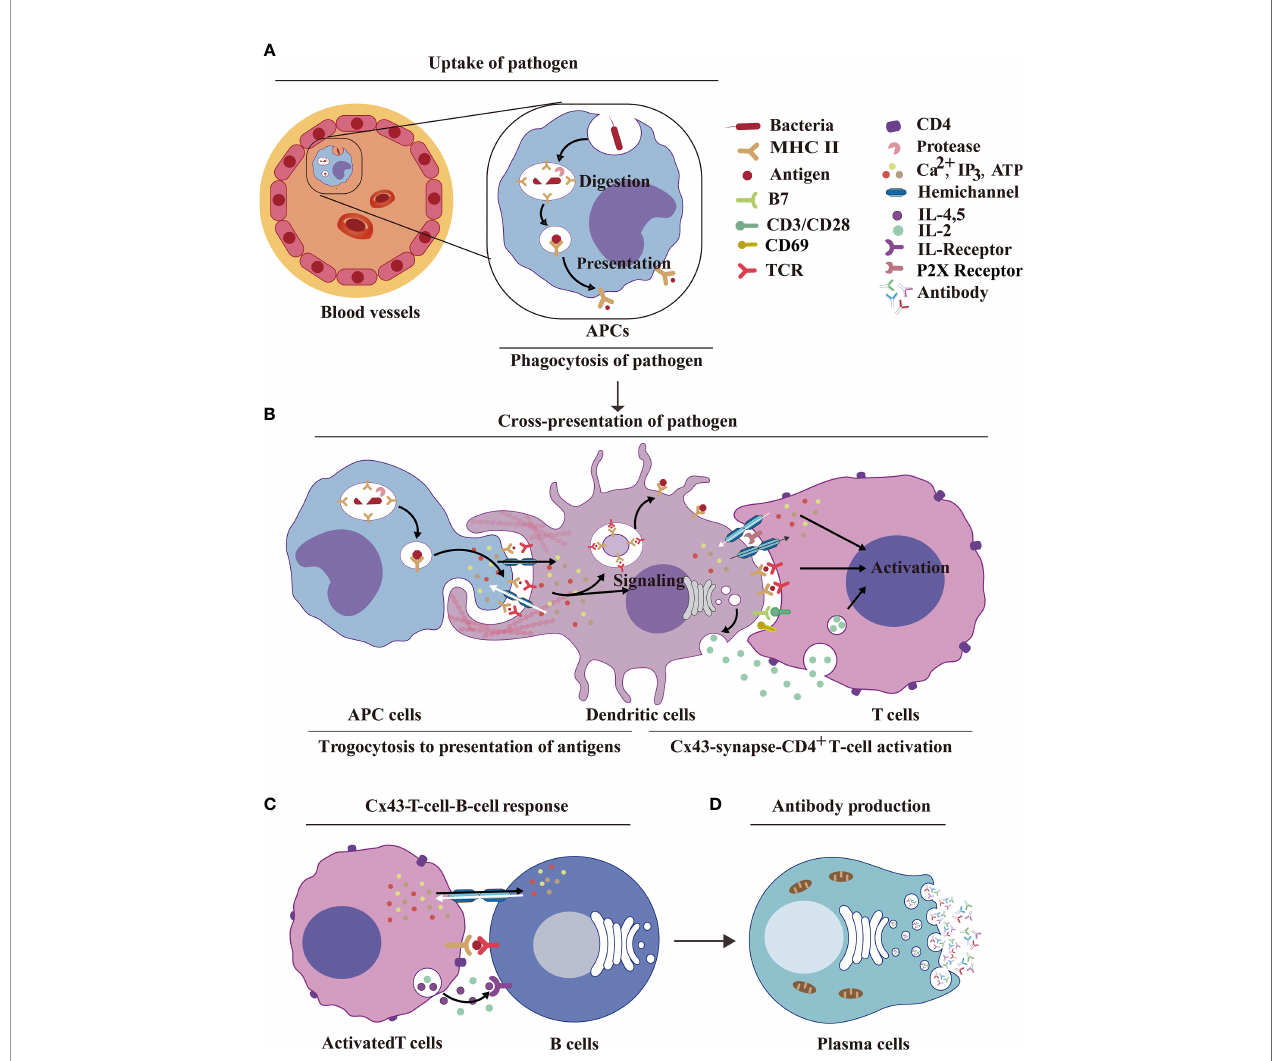
FIGURE 4 | HCs and IGLDCPs activate innate – adaptive immunity. (A) Uptake of pathogens by APCs. The pathogenic antigens are phagocytosed by APCs and digested by proteases to form peptides, which are then transmitted by MHC molecules to the cell surface by phagocytosis. (B) Dendritic cell Cx43s are dependent on trogocytosis for antigen delivery to T cells. The antigen is processed by APCs and binds to MHC receptors on the APC membrane. The HCs and IGLDCPs in innate – adaptive immunity recognize and remember speci fi c pathogens to trigger immunity. The former facilitates ATP release and autocrine feedback mechanisms that control Ca 2+ entry. GJs between monocytes and CD8 + DCs transfer antigens via Cx43-synapse-CD4 + T cells (59, 60). (C) Cx43-T-cell – B-cell response. The activated T cells facilitate the opening of HCs, which liberally release ATP into B cells. This results in the simultaneous release of IL-2, IL-4, and IL-5, which act on the IL-R receptor and further stimulate B cells to produce antibodies. (D) Antibody production. Activated B cells form plasma cells, which produce antibodies (61). HC, hemichannel; IGLDCP, Ig-like domain-containing protein; APC, antigen-presenting cell; MHC, major histocompatibility complex; DC, dendritic